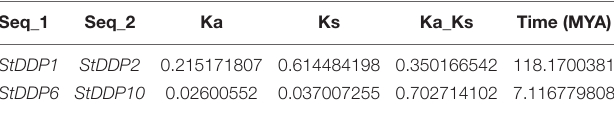
TABLE 2 | Gene duplication and selection pressure of StDDPs .